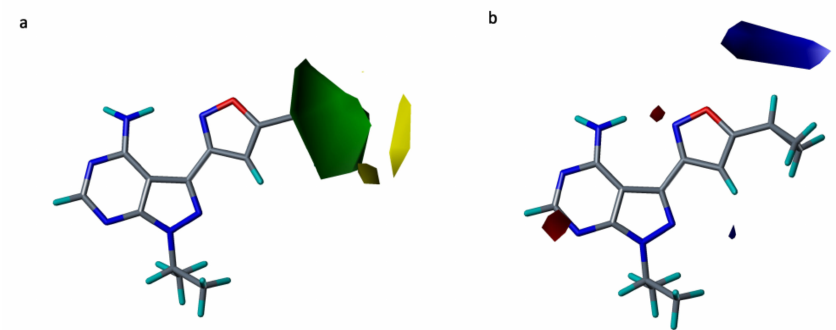
Figure 7. Contour maps for the selected CoMFA model. ( a ) Steric contour map; ( b ) electrostatic contour map—green contour shows the regions favorable for bulky substitutions and yellow con- tours shows the regions unfavorable for bulky substitutions; Blue contour favors electropositive substitutions while red contour favors electronegative